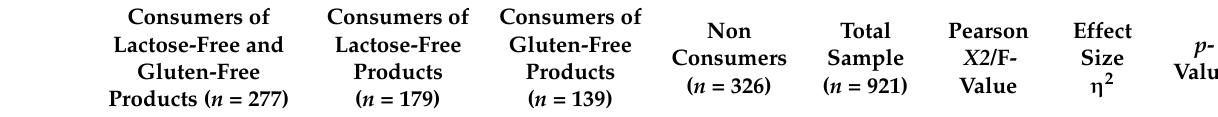
Table 4. Groups’ comparison on socio-demographic ad psychological